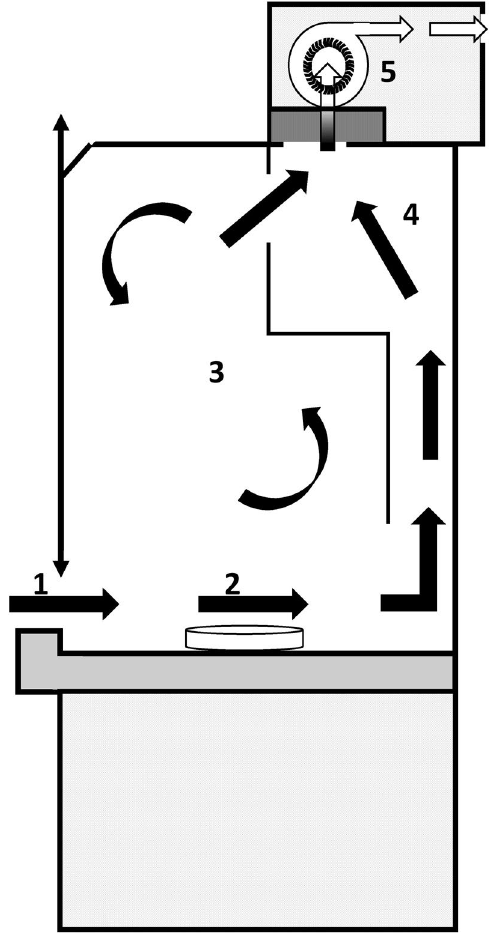
Figure 3. Image of a typical laboratory fume hood. A fume hood is a ventilated enclosure that provides protection of the operator and the environment from particularly hazardous substances like fumes, vapours, dusts and gases. During processing, ambient air flows into the fume hood through a vertically movable front sash (1). The unfiltered air flows across the work surface, over the sample (2) and circulates in the workspace (3). Air and all airborne contaminants are directed through an air exhaust duct (4) into the exhaust fan (5) and suctioned out of the fume